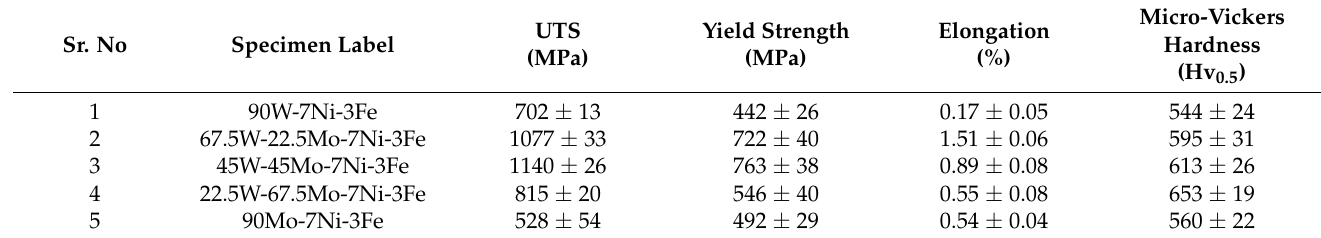
Table 4. Mechanical properties of all sintered